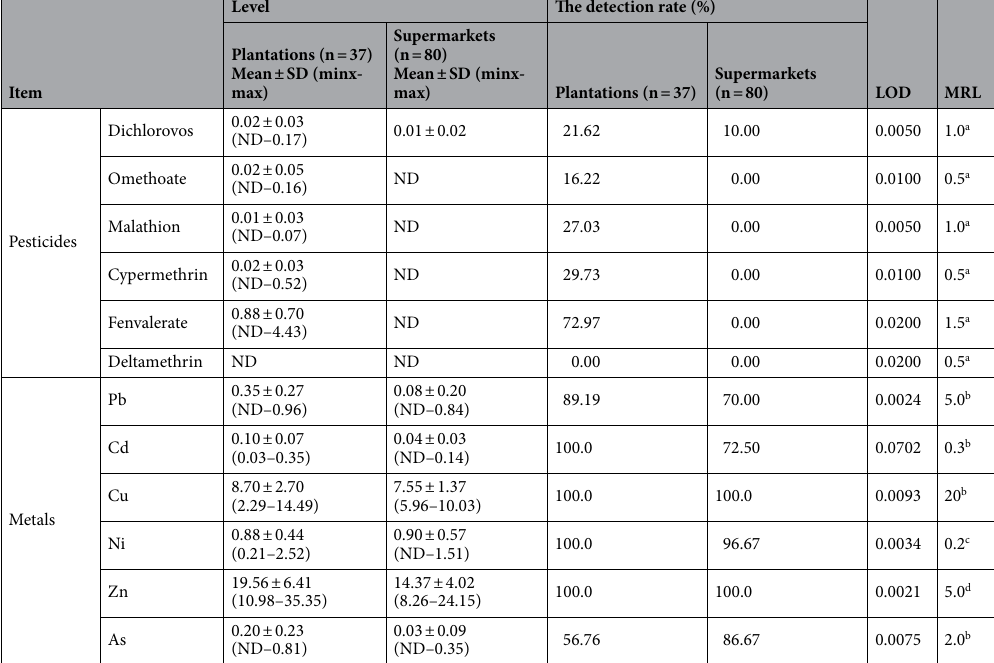
Table 1. Levels of pesticides and metals in Goji berries (mg/kg). MRL means maximum residue limits, ND means not detected. a Means European maximum residue limits of pesticides 27 . b Means China MRLs of metals for medicinal plants and preparations 30 . c Means China MRL of Ni for fruits 28 . d Means China MRL of Zn for fruits 29 .